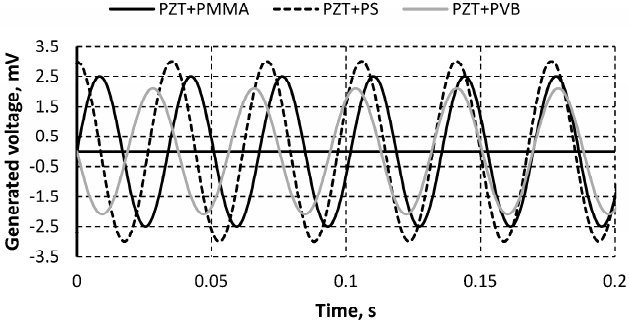
Figure 8. Generated voltage by periodically excited specimens.